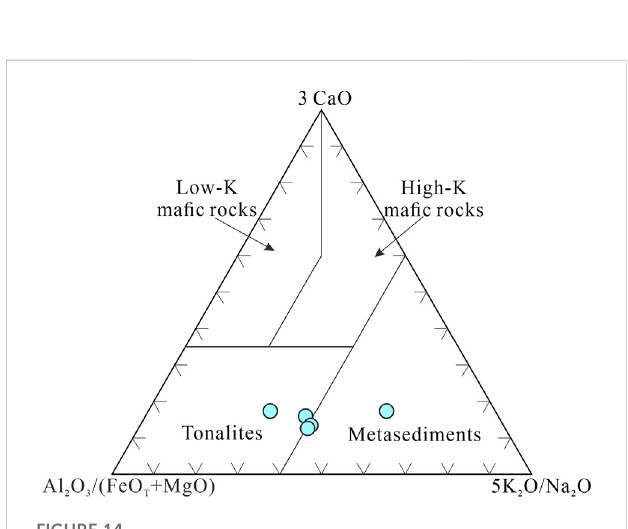
FIGURE 14 3CaO − Al 2 O 3 /(FeO T /MgO) − 5K 2 O/Na 2 O triangle diagram for distinguishing the potential sources of granite (Laurent et al.,